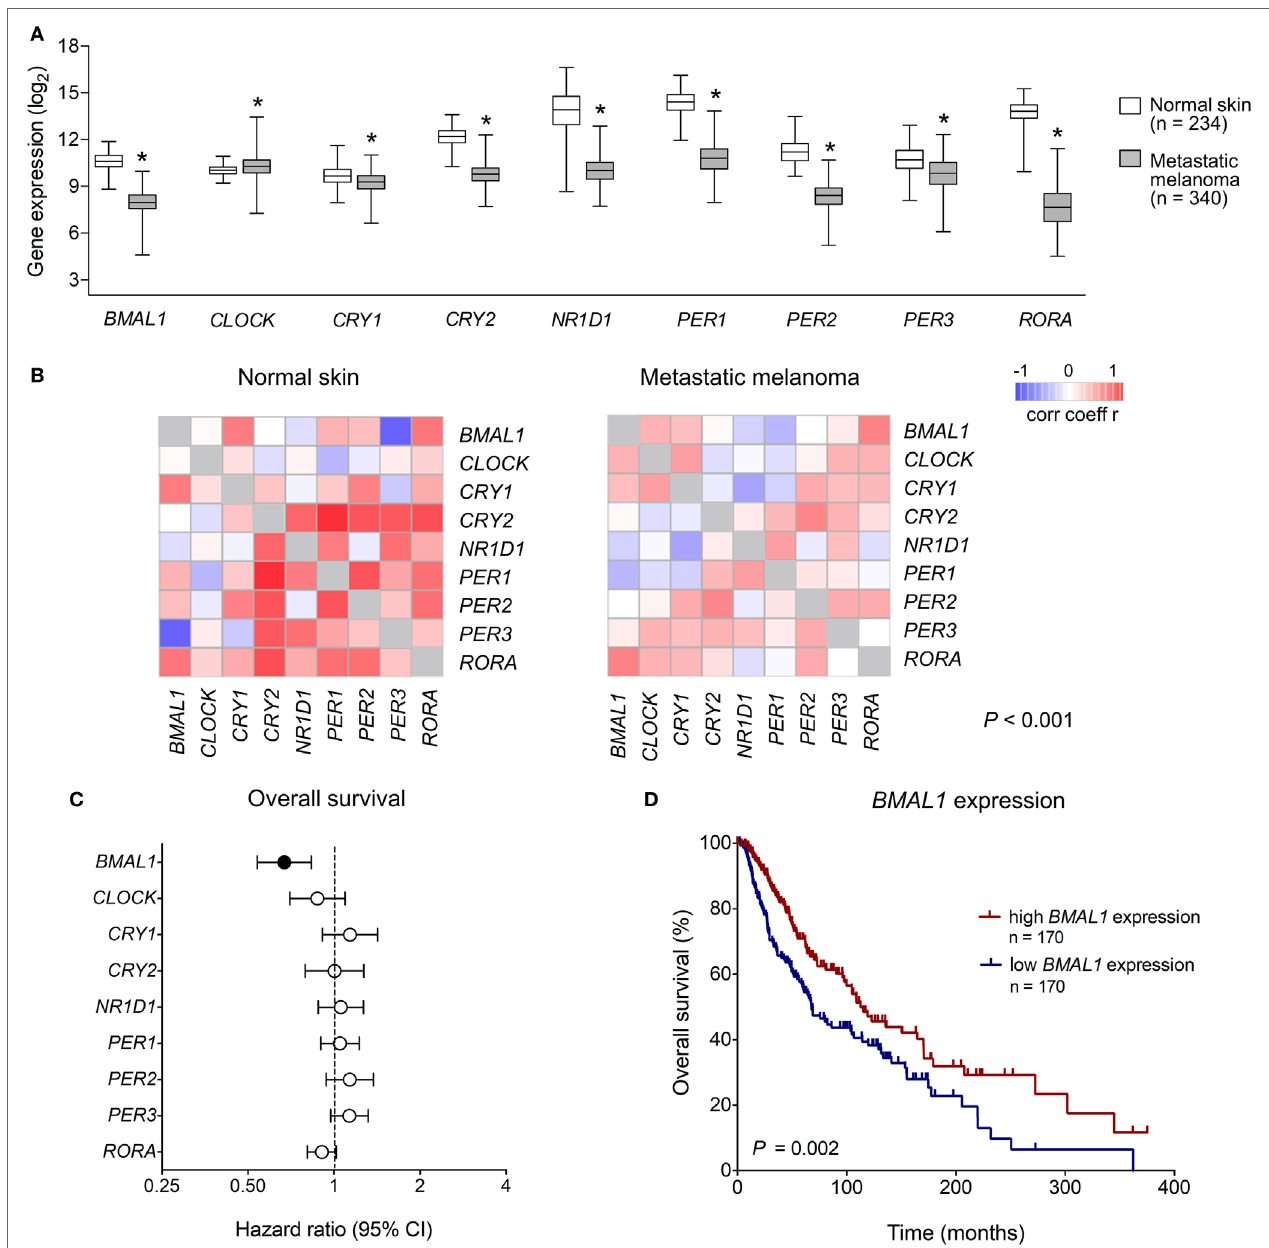
FigUre 1 | Clinical relevance of clock genes expression in metastatic melanomas. (a) RNAseq analysis of clock genes expression in genotype-tissue expression (GTEx) normal skins ( n = 234) and The Cancer Genome Atlas (TCGA) metastatic melanoma ( n = 340). Expression values were estimated using RSEM and log 2 ( x + 1) transformed. The boxes extend from the 25th to the 75th percentile, the central bold line shows the median, and whiskers are drawn from minimum to maximum values. Comparisons were performed using the two-sided Wilcoxon–Mann–Whitney test. *Significantly different from normal skin ( P < 0.05). (B) Co-expression matrix showing pairwise Spearman’s correlation coefficients of clock core genes in GTEx normal skins ( n = 234) and TCGA metastatic melanomas ( n = 340). Networks were compared using the CoGA software. (c) Univariate Cox analysis of overall survival according to the expression of clock core genes in TCGA metastatic melanomas. Hazard Ratios including 95% confidence intervals are shown. Genes with a significant prognostic value ( P < 0.05) are marked in black. (D) Kaplan–Meier survival curve according to the expression of aryl hydrocarbon receptor nuclear translocator-like protein 1 ( BMAL1 ) in TCGA metastatic melanomas. The median expression of BMAL1 was used as the cutoff to dichotomize the population. Comparisons were performed using the log-rank